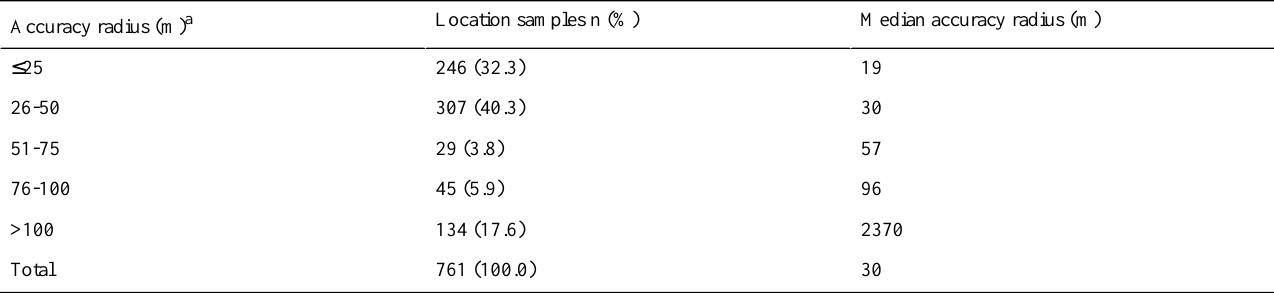
Table 5. Accuracy of global positioning system (GPS) location